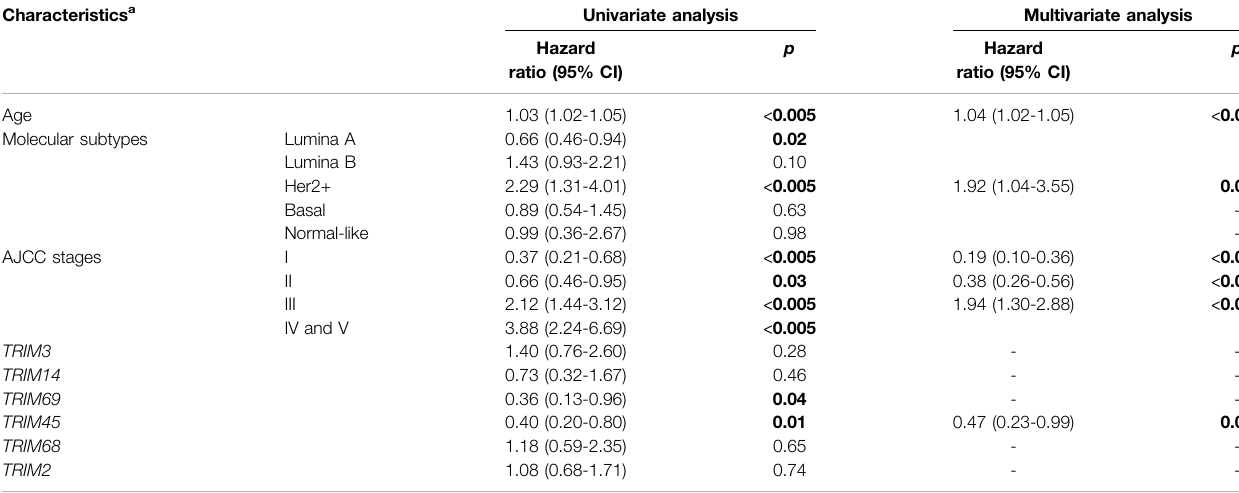
TABLE 3 | Univariate and multivariate Cox proportional hazards analyses for TRIMs, ages, stages, and molecular subtypes in breast cancer. Characteristics